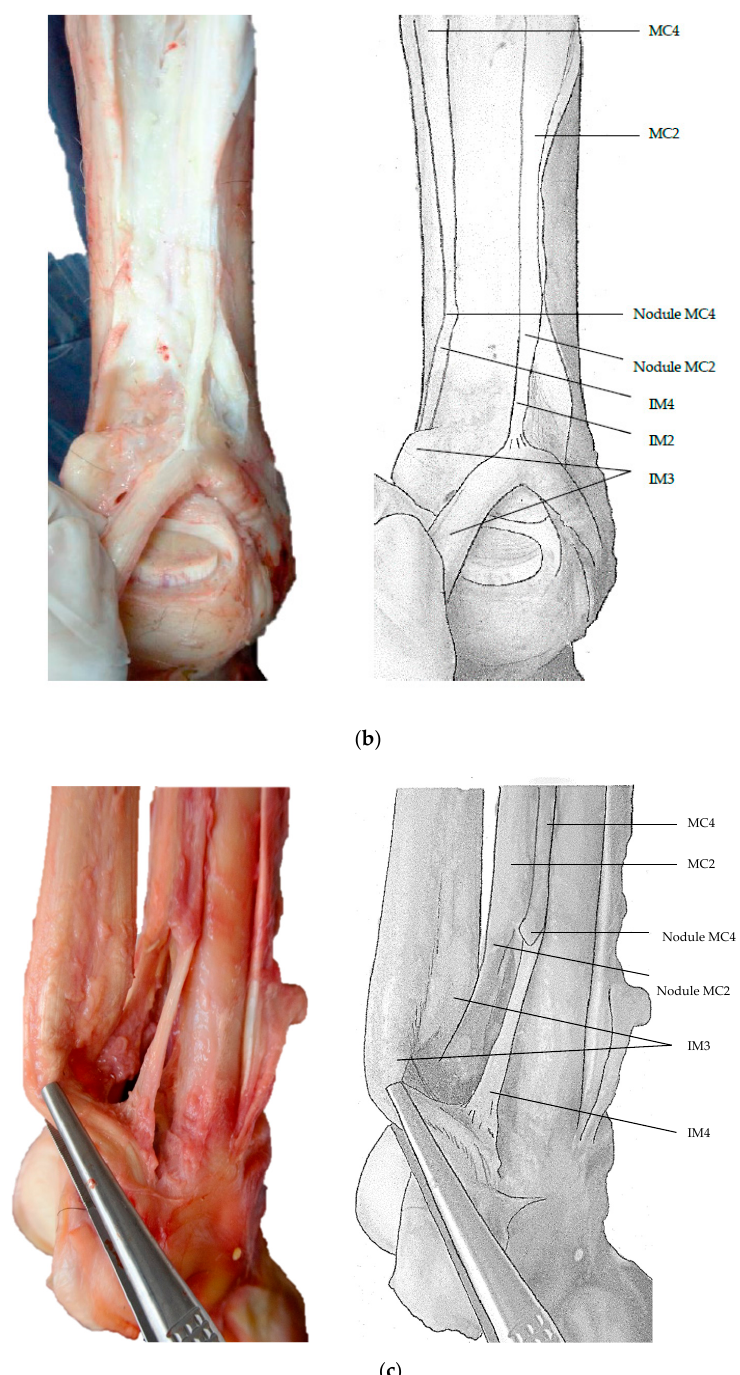
Figure 3. Resection of the distal foreleg revealing IM2 and IM4. ( a ). Left foreleg: the palmar view from the carpus to proximal Ph.I in a seven year old female E. caballus (Dutch Konik) from De Rug, The Netherlands, displaying the interosseous muscles IM2 and IM4, and resected IM3. ( b ). Left foreleg: the palmar view from the carpus to proximal Ph.I in a 11 year old male E. przewalskii (Przewalski’s horse) from Hortobagy National Park, Hungary, displaying interosseous muscles IM2 and IM4, and the resected IM3. ( c ). Right foreleg: the lateral palmar view from the carpus to proximal Ph.I in a 23 year old female E. quagga boehmi (Grant’s zebra) from Wildlands Adventure Zoo Emmen, The Netherlands, displaying interosseous muscle IM4 and the resected IM3 (IM2 was not present). MC2: metacarpal II, MC4: metacarpal IV, IM3: interosseous muscle III, IM4: interosseous muscle